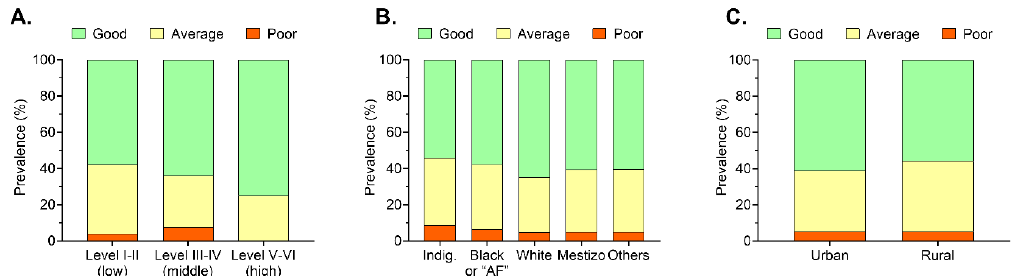
Figure 1. Prevalence of the Mediterranean Diet Quality Index (KIDMED) score according to the different sociodemographic factors. Data is presented in percentages (%). A. Prevalence of the KIDMED score according to SES. B. Prevalence of the KIDMED score according to ethnicity. C. Prevalence of the KIDMED score according to living area. AF: Afrodescented.